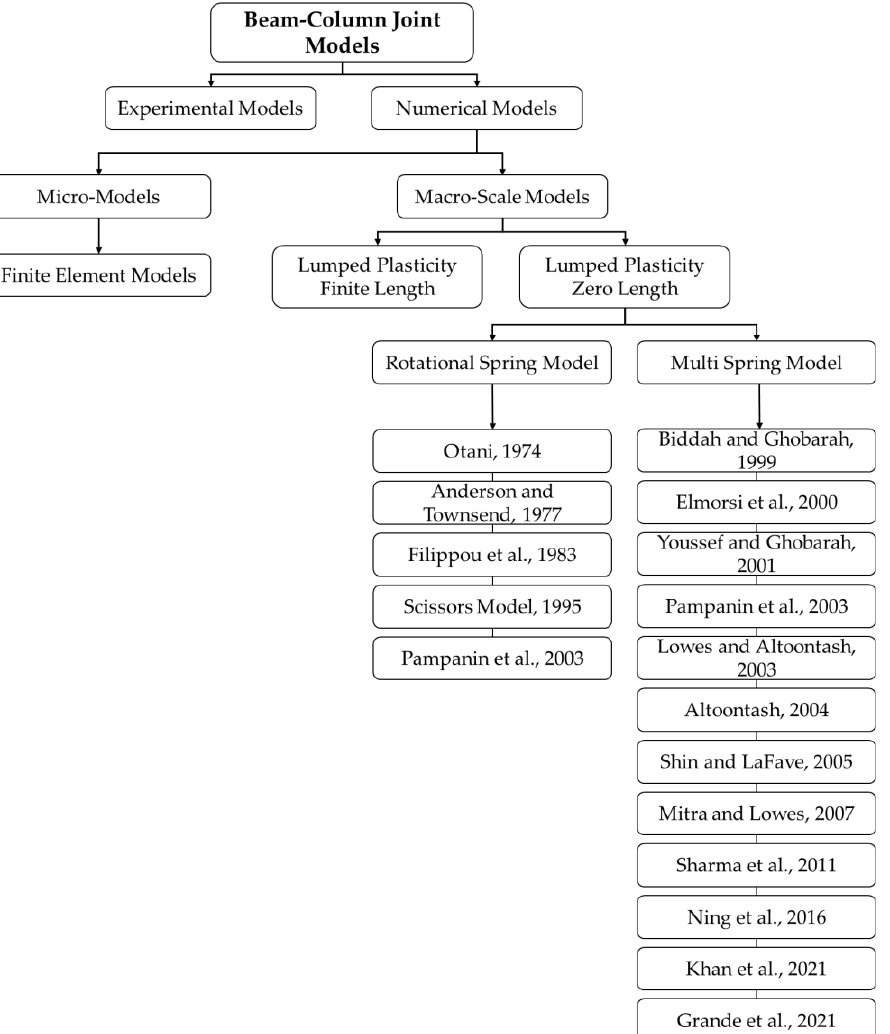
Figure 1. Classification of common models used for analysis and assessment of RC joints.